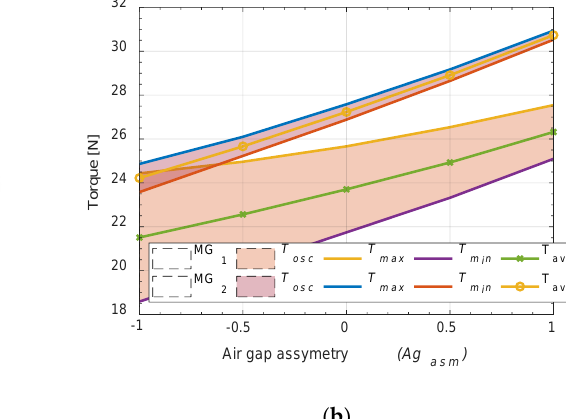
( b ) Figure 11. Global force components acting on whole modulator vs. inner rotor angle and air gap asymmetry ( Ag asm ), for the two gear variants (MG 1 and MG 2 ) at ( a ) max load; ( b ) FFT spectra of magnetic torque. The value of the axial force is strongly dependent on the operating point, as illus- trated by the characteristics shown in Figure 12. As shown on the characteristics, both gear variants are relatively well-balanced in the idle state, considering magnetic forces in the Z axis. However, moving to the rated load with the symmetry of the air gaps, as in the prototype, causes the axial load facing the low-speed rotor of approx. 300 N to appear. As is commonly accepted, in the extreme case, when analyzing the asymmetry variant Ag asm = +1, the value of the axial force approaches 1 kN facing the low-speed rotor. When using the opposite asymmetry variant Ag asm = − 1, the axial force facing the high-speed rotor ap- pears. As it is commonly accepted, electromechanical transducers are built for a given